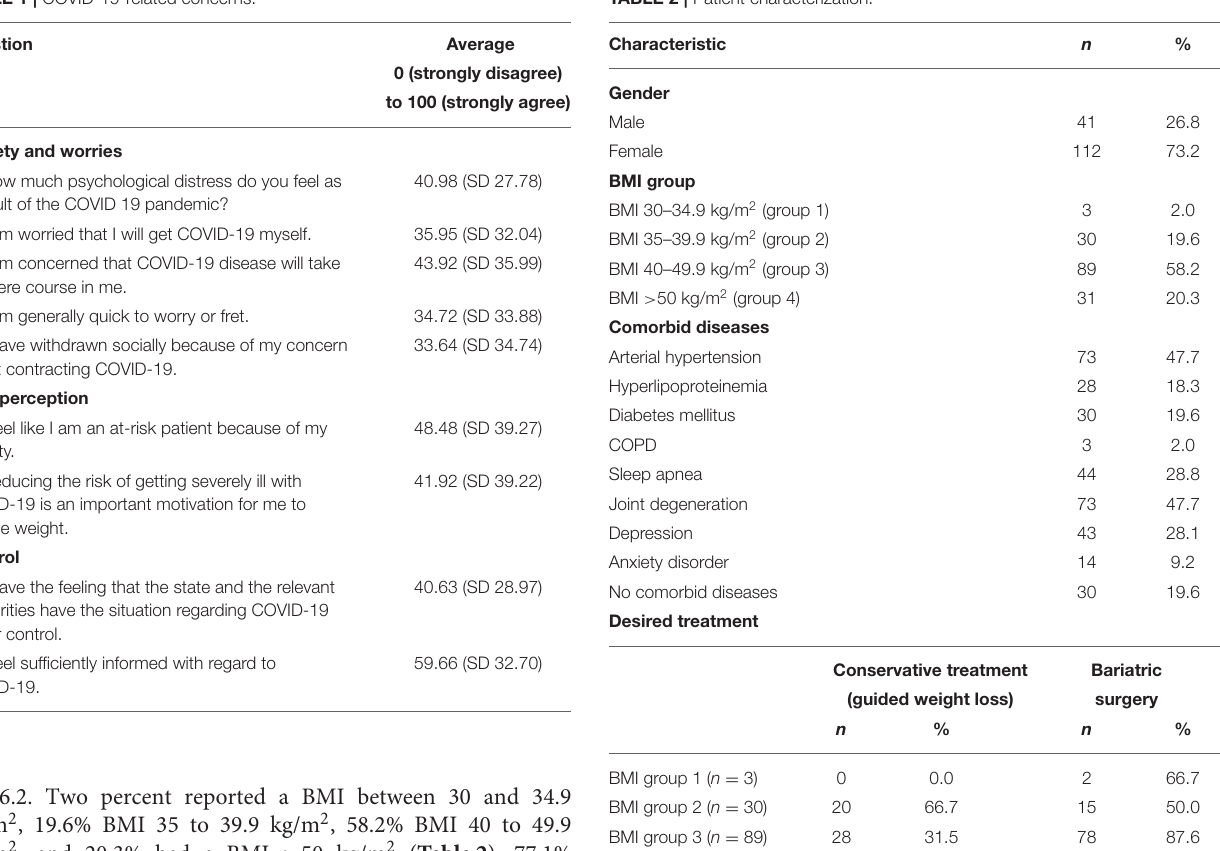
TABLE 1 | COVID-19-related